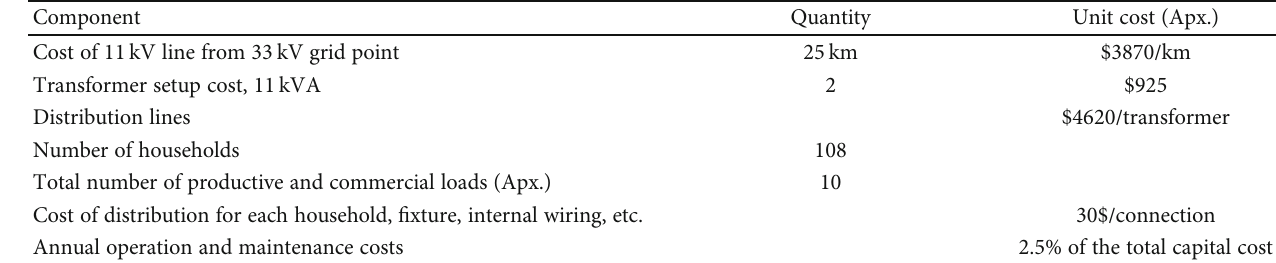
Table 2: Cost of grid